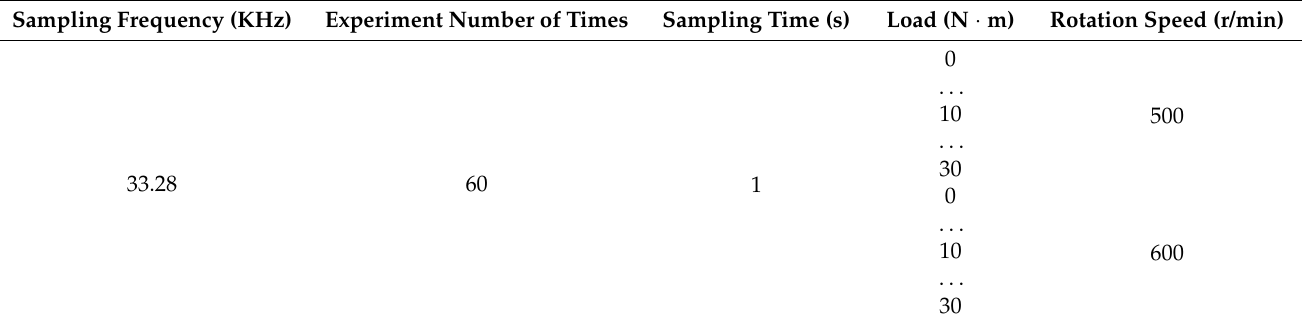
Table 7. Experimental gear